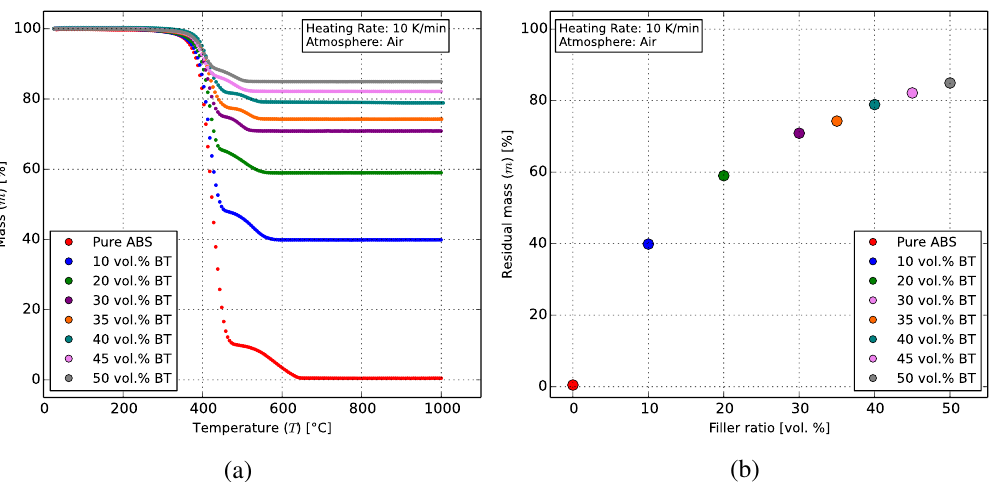
Figure 8. Thermogravimetric behavior of the ABS-BT composite feedstock with up to 50 vol % BT. ( a ) ABS can be seen to burn away between 400 and 650 ◦ C. The remaining ceramic masses remained consistent over the different phases of the process, with the 50 vol % composite correlating to 84.9 wt %. ( b ) The remaining ceramic masses after thermogravimetry.